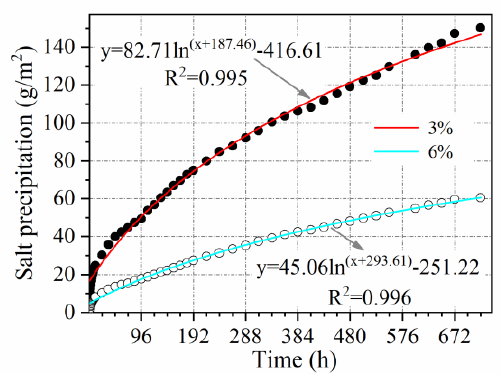
Figure 17. Effect of salt content on salt precipitation.